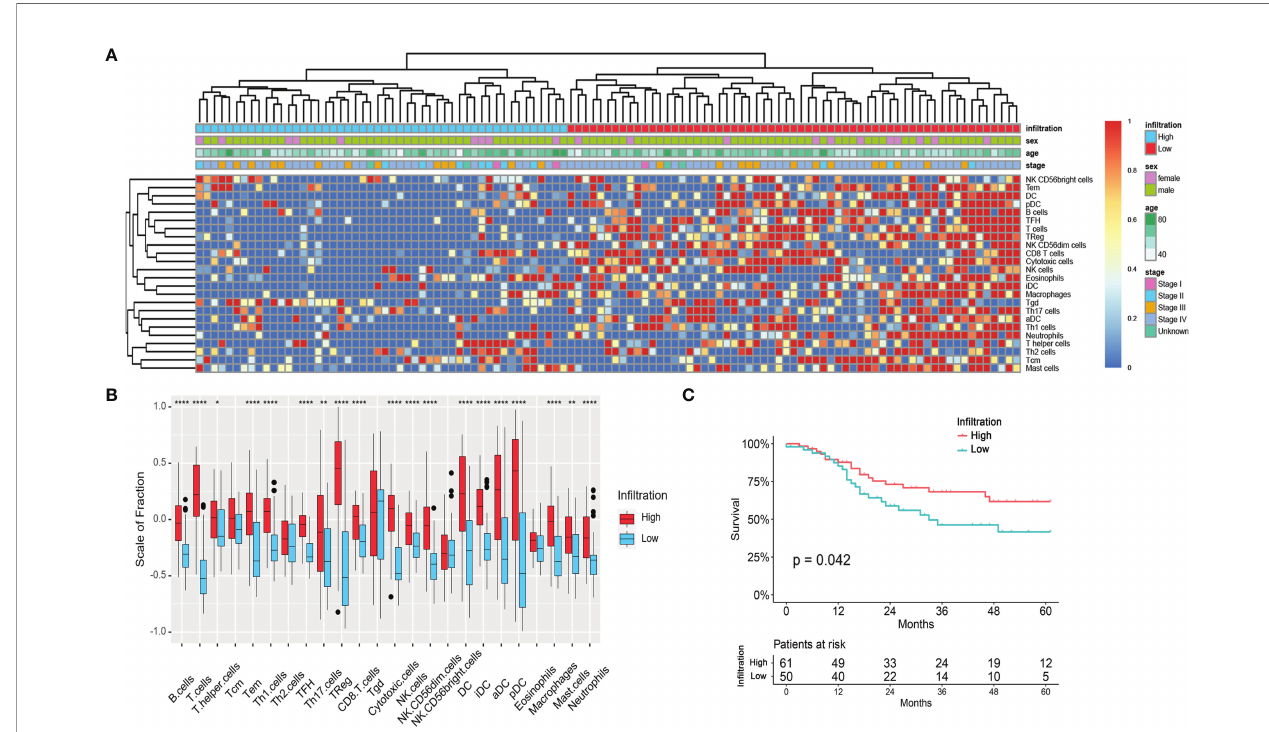
FIGURE 1 | Immune in fi ltration status of the LSCC patients in the TCGA cohort. (A) Unsupervised clustering of 24 types of immune cells for 111 LSCC patients. (B) Fraction of immune cells in LSCC patients with high-in fi ltration and low-in fi ltration phenotypes. *p < 0.05; **p < 0.01; ****p < 0.0001. (C) Survival analysis of LSCC patients with high-in fi ltration and low-in fi ltration